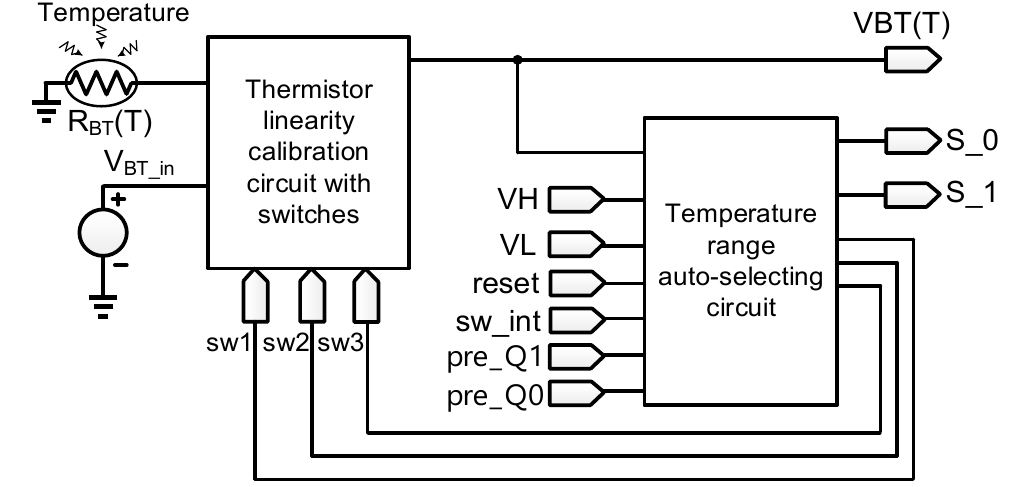
Figure 1. The block diagram of the proposed temperature sensor.